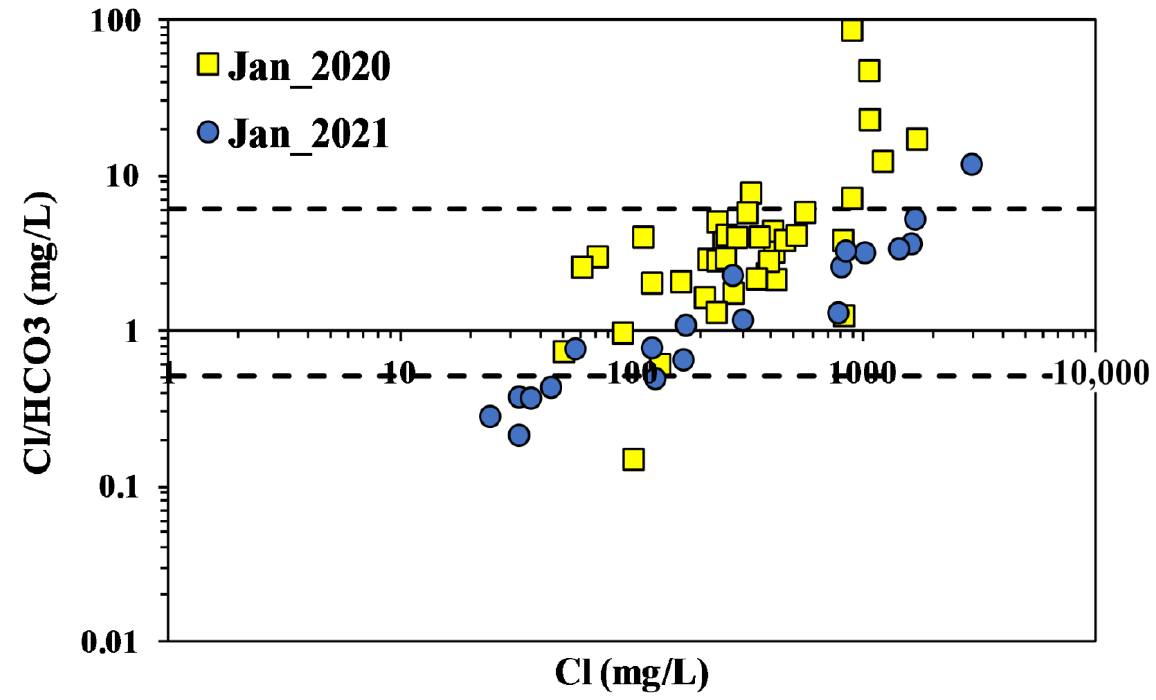
Figure 12. Cl − /HCO 3 − ratio plot for classification based on the salinization amount.